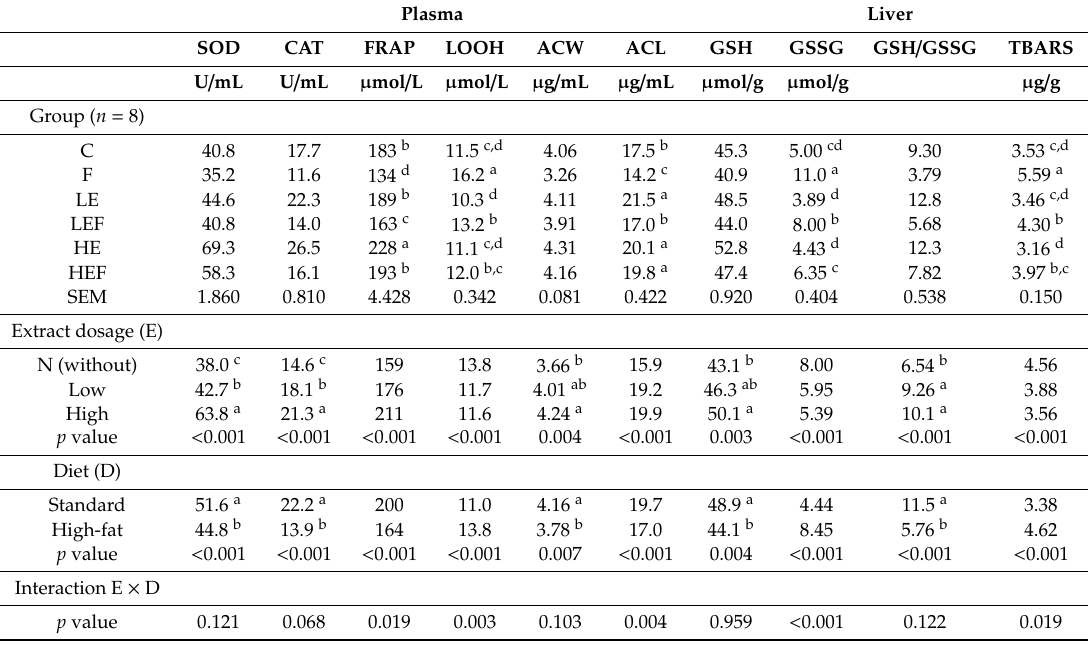
Table 2. Redox status of the plasma and liver of rats fed the experimental diets *.